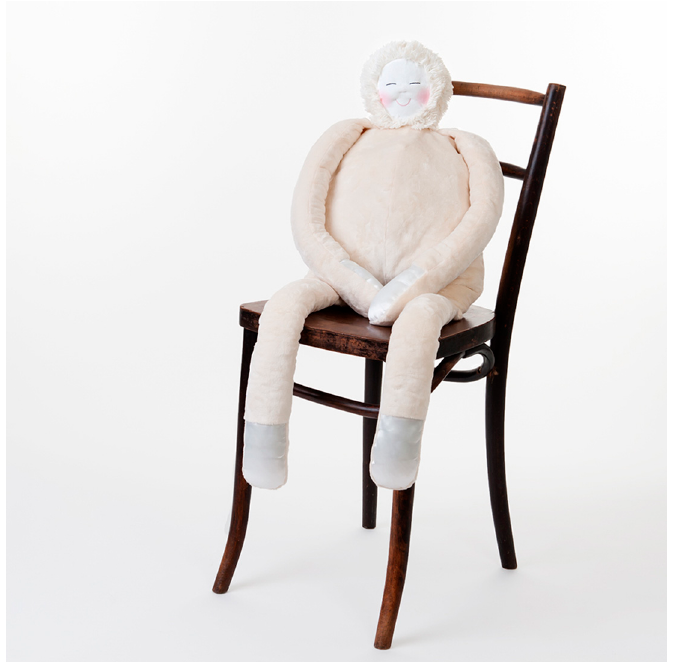
Figure 2. HUG by LAUGH ® therapeutic comforter.